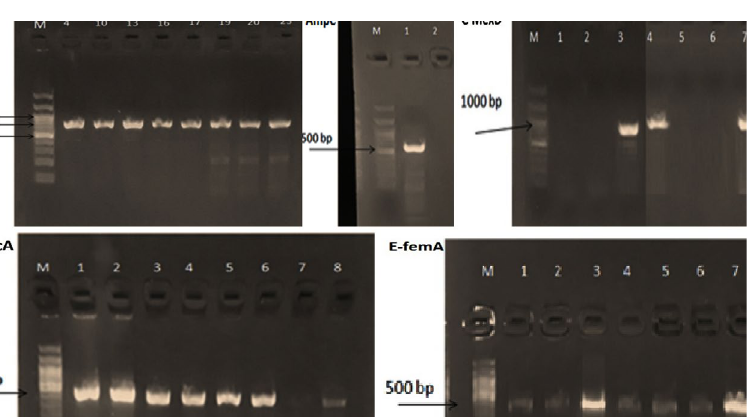
Fig. 3. Agarose gel of the investigated bacterial PCR products of the selected genes; A. TEM (799 bp), B. AmpC (576 bp), C. MexD (951 bp), D. mecA (533 bp), and E. femA (509). The bands that appeared on the agarose gel expressed only the positive results` so, the negative results are not represented. M is the DNA ladder (gene ruler 100 bp) purchased from Table 4. Screening of the resistance genes distributed in the clinical and non-clinical bacteria Bacterial strain Source